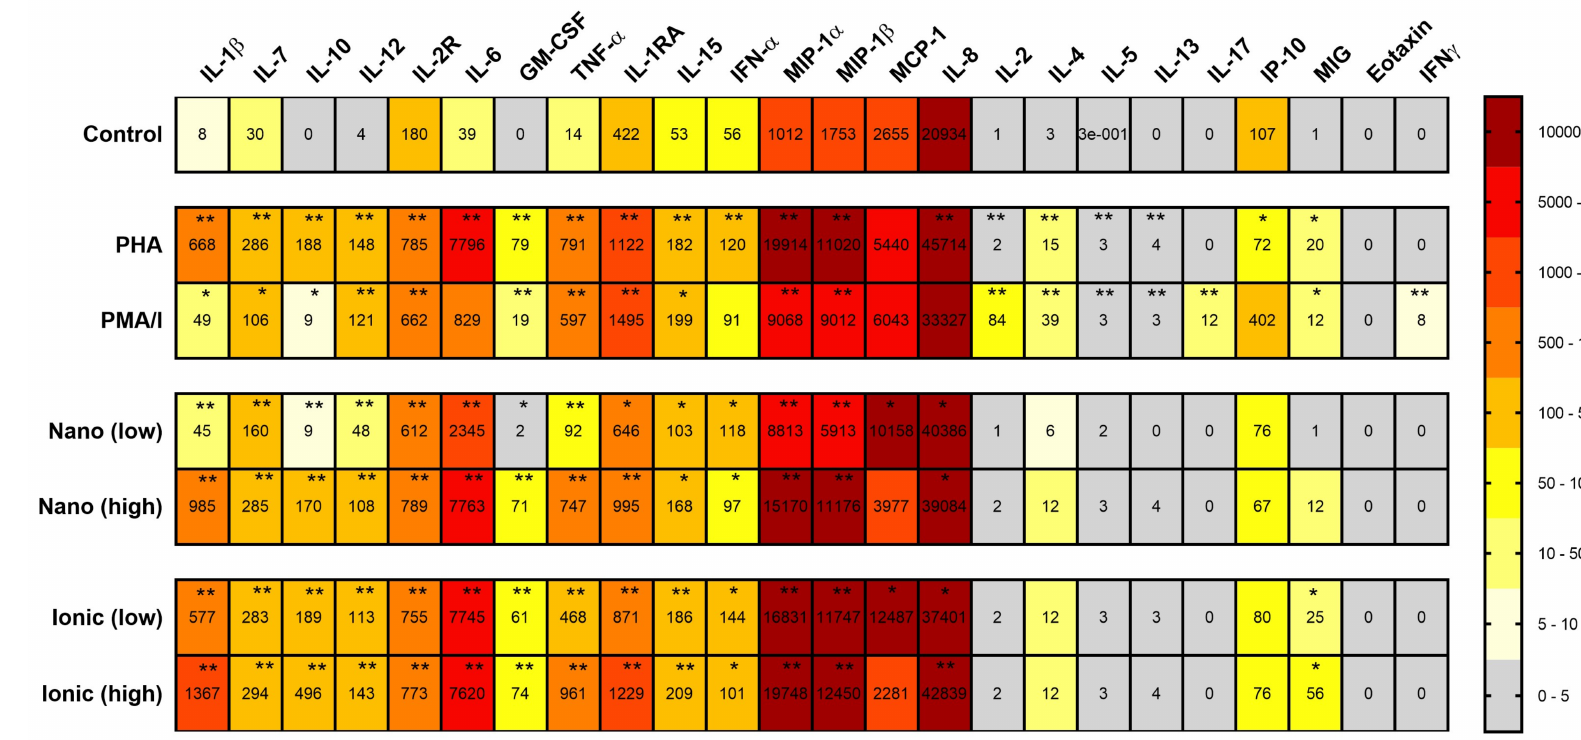
Figure 3. Statistical significance and median concentration (pg/mL) levels for cytokines and chemokines after PBMC stimulation in 24 h with low and high concentrations of nano-TiO 2 , ionic-Ti and positive controls (PHA and PMA) versus unstimulated cells. * p < 0.05, ** p < 0.001 compared to control using Wilcoxon signed rank test. Abbreviations: interleukin (IL), receptor (R), granulocyte-macrophage colony-stimulating factor (GM-CSF), tumor necrosis factor (TNF), interferon (IFN), macrophage inflammatory protein (MIP), monocyte chemoattractant protein (MCP), interferon gamma induced protein-10 (IP-10), monocyte induced by gamma interferon